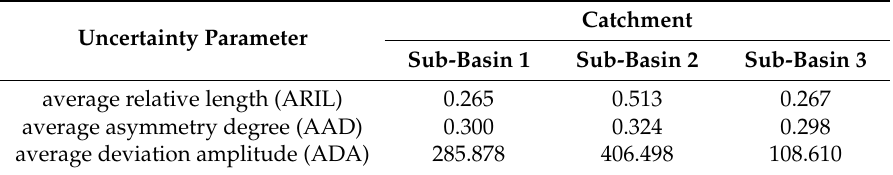
Figure 6. Comparison of 95% confidence intervals of the runoff at the three sub-basins. Table 4. Comparison of uncertainty parameters for the analyzed simulation